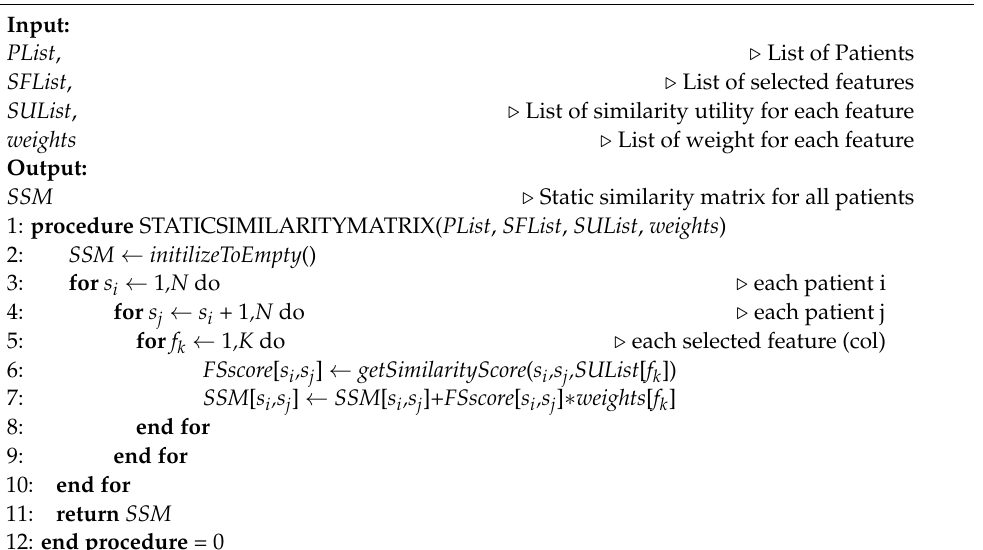
Algorithm 1. Static data similarity evaluation algorithm